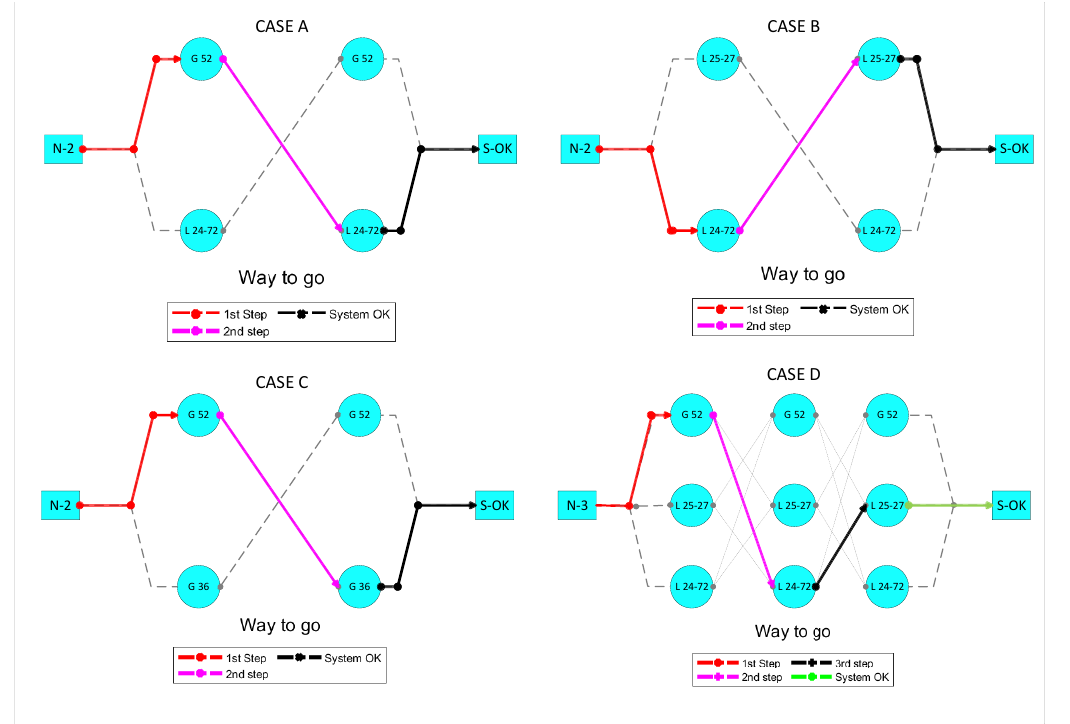
Figure 7. Decision tree for the entry of EPS elements, cases A, B, C, and